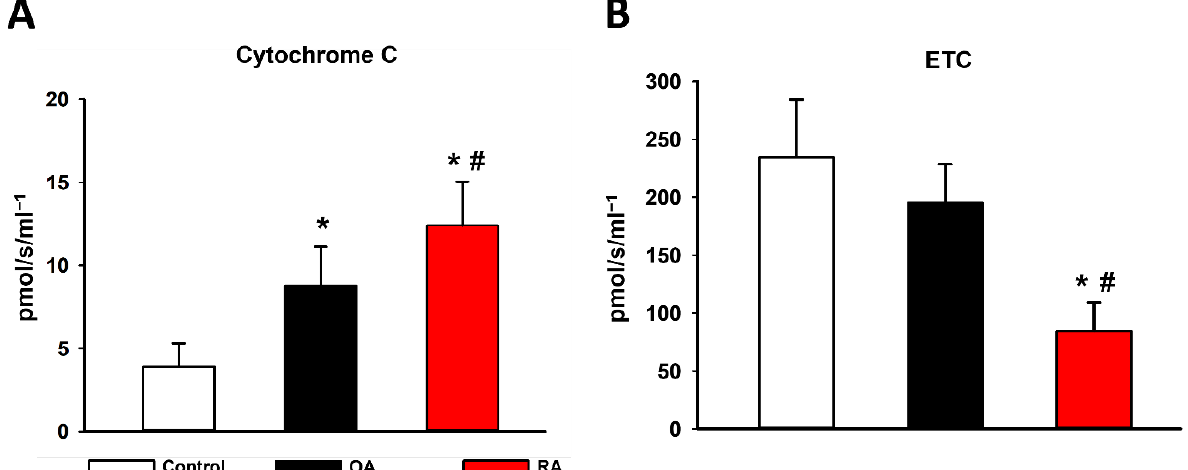
Figure 2. Cytochrome C induced respiration and the ETC of synovial mitochondria. ( A ) Cytochrome C release assessed by adding exogenous cytochrome C to the sample in the presence of glutamate (Glut) and malate (Mal) or succinate (Succ). ( B ) Electron transport chain (ETC) induced by the protonophore p-trifluoromethoxy-phenyl-hydrazine (FCCP). The RA group is marked with red. Black represents the OA group. The control group is marked with white. Data are presented as means ± SD. * p < 0.05 vs. control; # p < 0.05 vs. OA (one-way ANOVA, Tukey’s test).